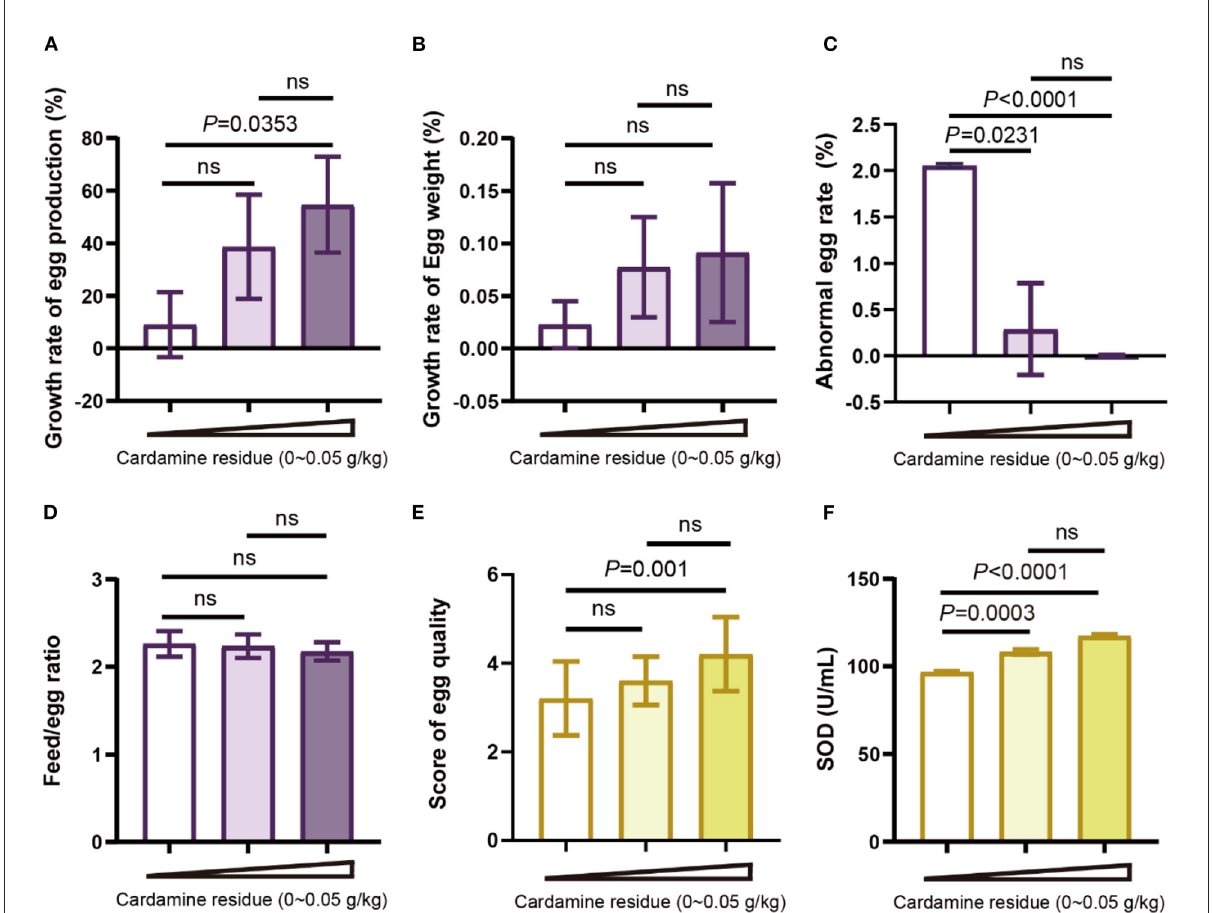
FIGURE2 Effects of DCH on production performance and egg quality of laying hens. (A) Growth rate of egg production from day 0 to day 30. (B) Growth rate of egg weight from day 0 to day 30. (C) Abnormal egg rate of day 30. (D) The feed-egg ratio of each group after 30 days of experiment. (E) Egg quality scoring for each group. (F) SOD in eggs of each